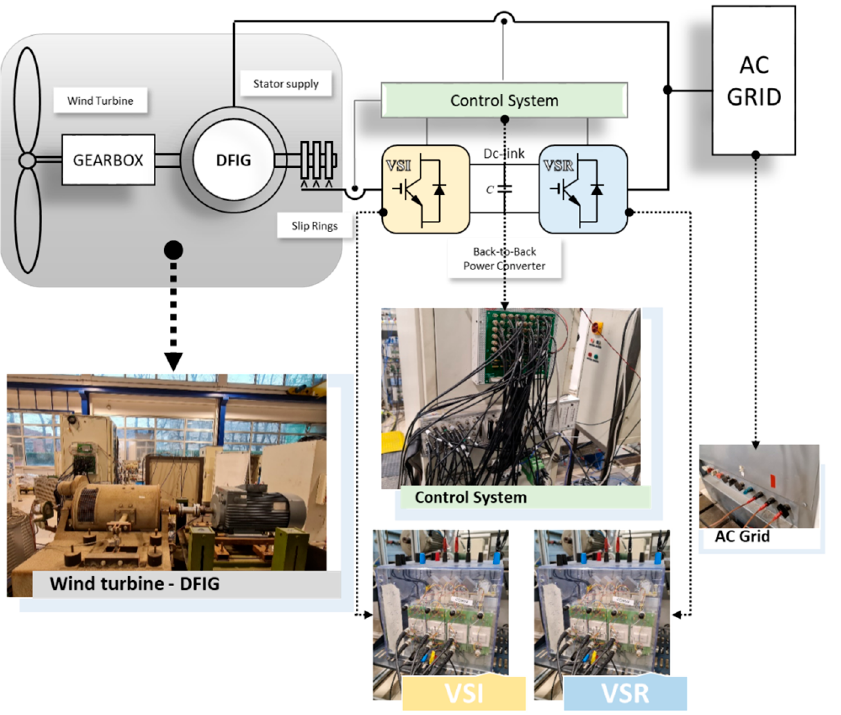
Figure 3. Experimental setup.